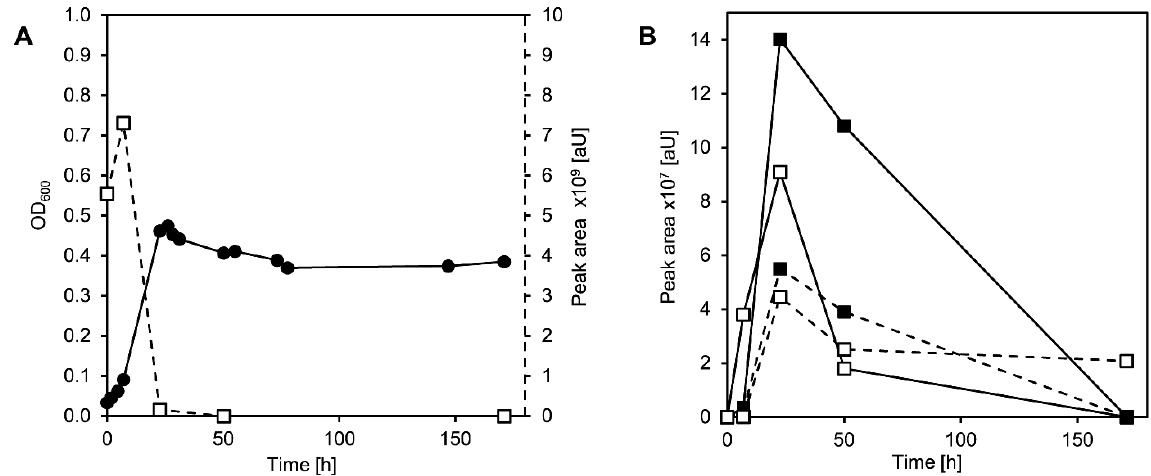
Figure 3. ( A ) Growth (filled circles) of a co-culture of Pseudomonas stutzeri Chol1 pBBR1MCS-5:: hsh2 and Sphingobium sp. Chol11 Δ scl1 with cholate (open squares, second axis). ( B ) Formation of THADD (XII in Figure 1; filled squares, continuous line), DHSATD (XI; open squares, continuous line), THSATD (V; filled squares, dotted line), and MDTETD (XIII; open squares, dotted line). This figure shows the results of a single experiment representative for at least three reproducible experiments.